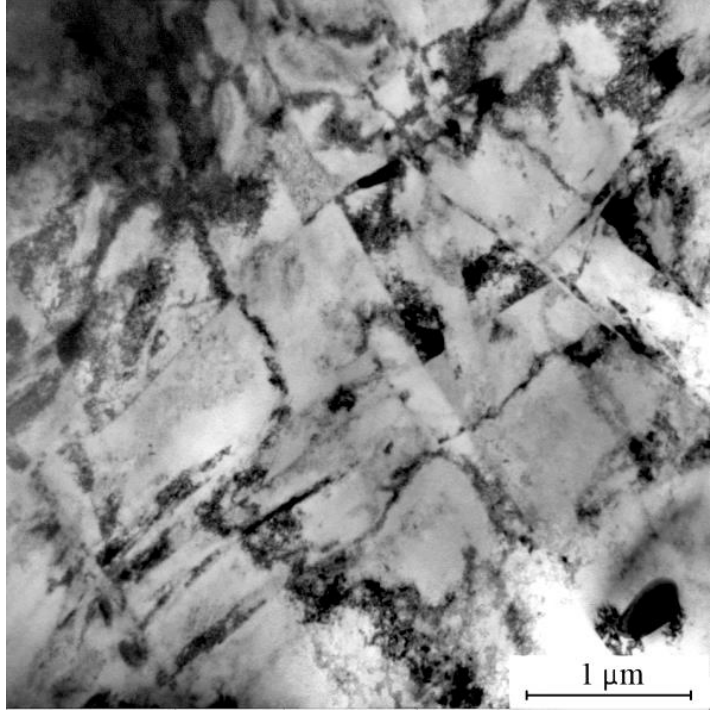
Figure 10. Intersecting microshear bands in grain volume aftеr abc pressing to e = 1.84.